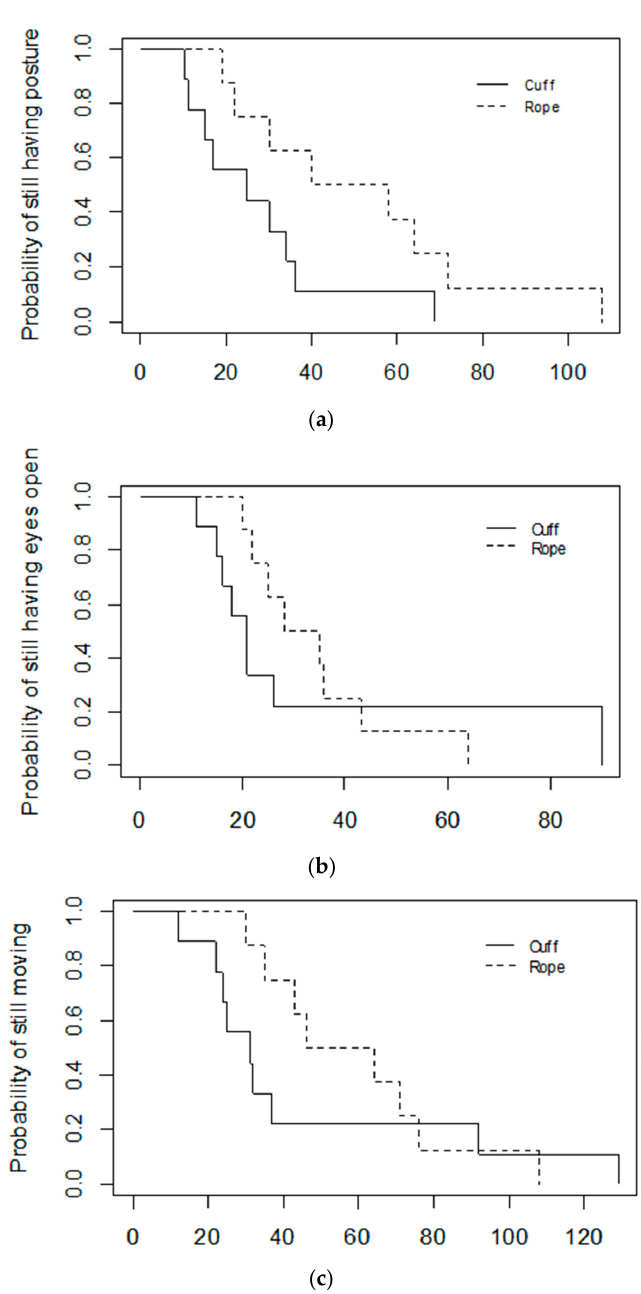
Figure 6. Kaplan–Meier graphs of ( a ) Latency to lose posture, ( b ) Latency to close eyes, ( c ) Latency to cease moving in 17 piglets that were successfully induced into a less-responsive state with either the cuff ( n = 9) or the rope ( n =